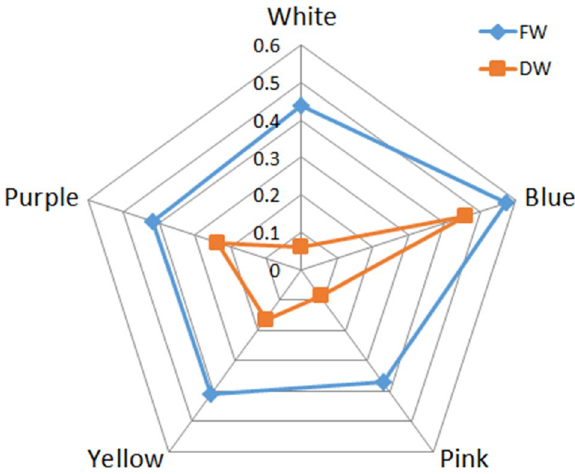
Figure 4. Effect of NaCl stress on the reduction rate of fresh weight (FW) and dry weight (DW) of the leaves of five Limonium sinuatum varieties. The reduction rate was calculated as (FW or DW under control condition − FW or DW under saline condition)/FW or DW under control condition ×